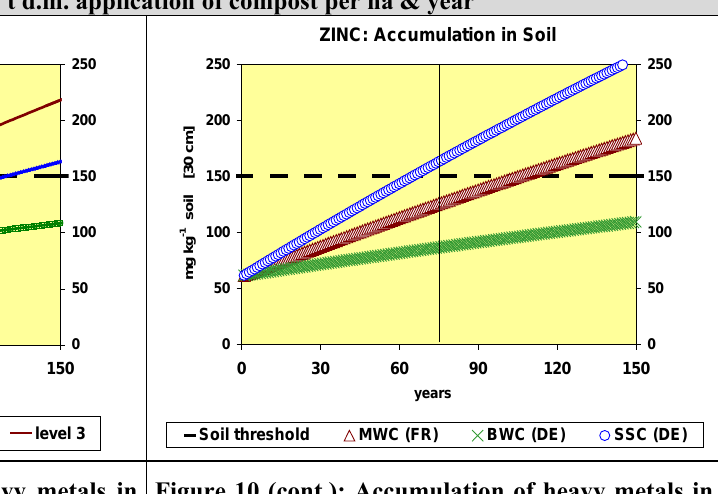
Figure 10 (cont.): Accumulation of heavy metals in soil assuming the continuous application of composts with metal concentrations at the 75 percentile of German biowaste and green waste composts (BWC), sewage sludge composts (SSC) and mixed waste composts from France